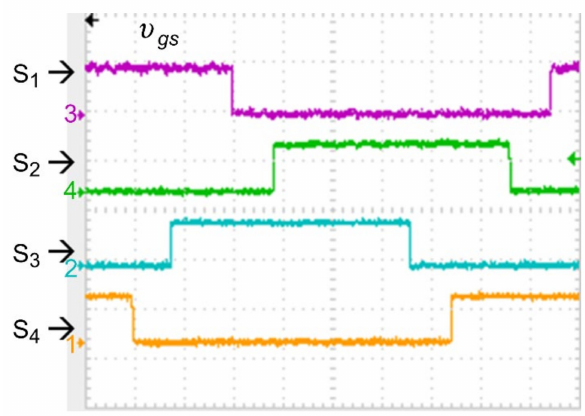
Figure 14. Waveforms of gate-source voltage, v GS , of the switch.